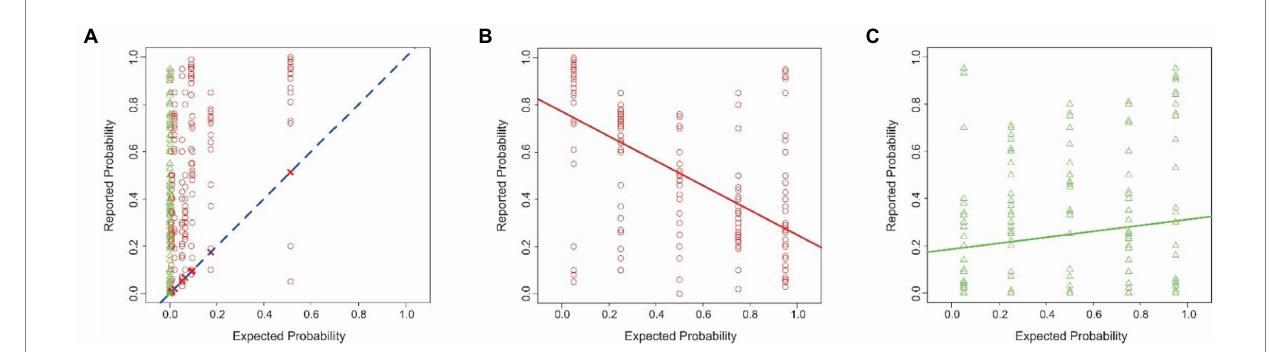
FIGURE 5 Estimation errors in Experiment 3. The data are plotted according to the conventions used in Figure 1. (A) Probability of enemy sniper estimated by the subjects is plotted here as a function of the corresponding theoretically expected probability. (B,C) Interaction between the false alarm rate and the binary decision of the reconnaissance drone. See text for details.